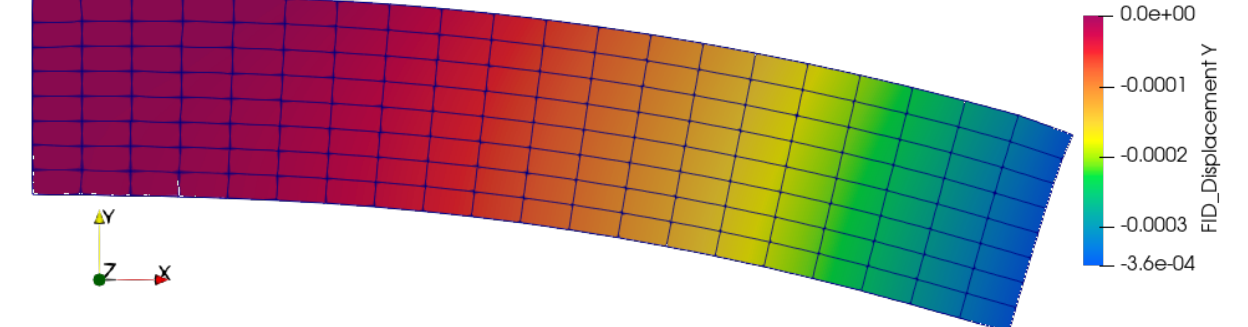
Figure 8. Resulting displacement at time=10